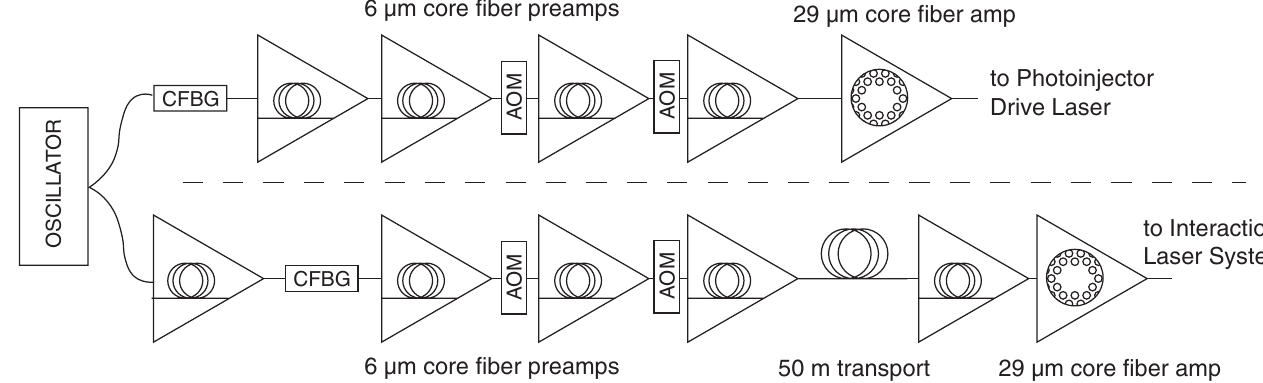
FIG. 2. Schematic diagram of the SLS architecture, showing the chirped fiber Bragg grating (CFBG), acousto-optic modulators (AOM), and the standard and photonic crystal fiber amplifier